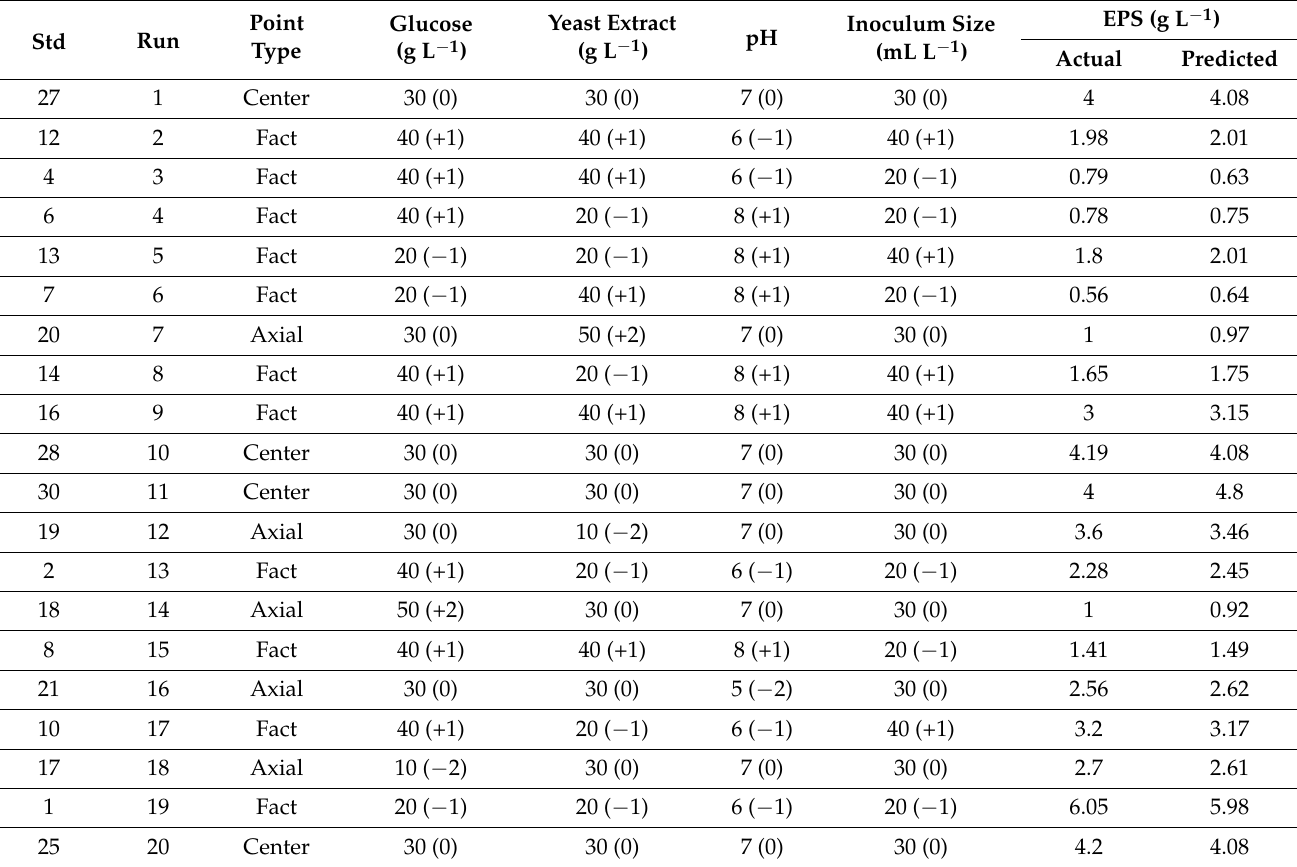
Table 1. Experimental CCD matrix in uncoded and coded values with actual and predicted EPS production by thermophilic B. haynesii